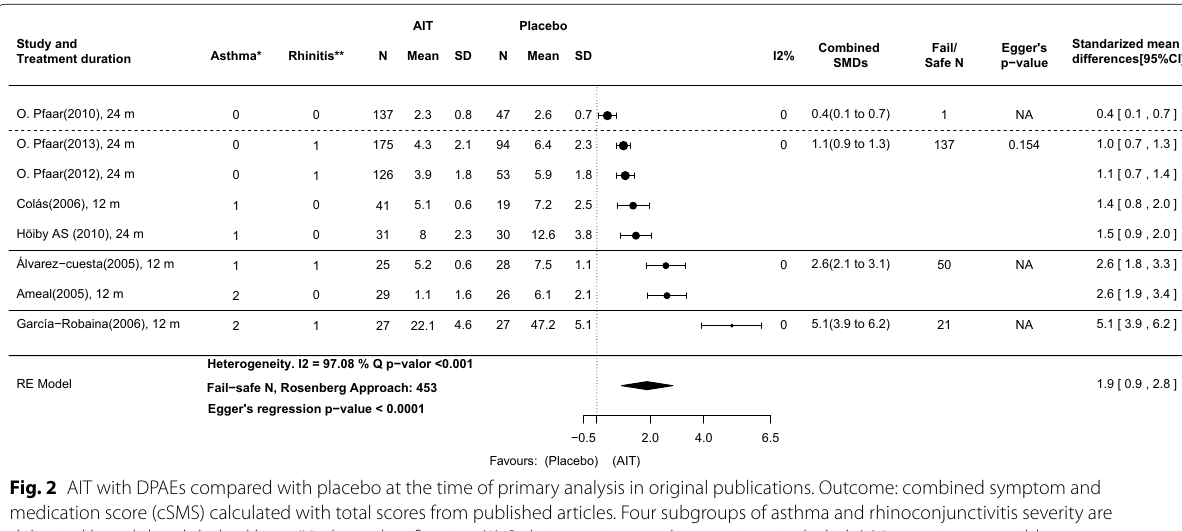
ARIA allergic rhinoconjunctivitis and its impact on Asthma, GINA global initiative for Asthma, PDCO European Medicines Agency. Paediatric Committee, PP Per protocol, SD Standard deviation